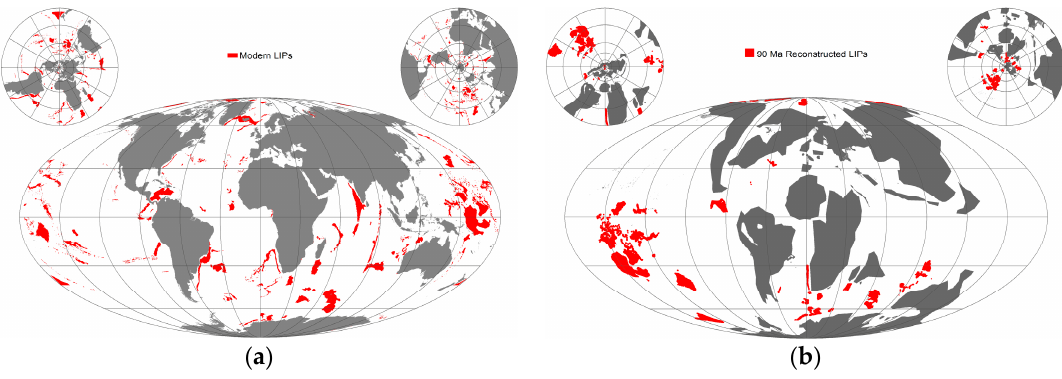
Figure 2. Distribution of Large Igneous Provinces (LIPs) in the ocean basins. ( a ) Modern; ( b ) 94 Ma.